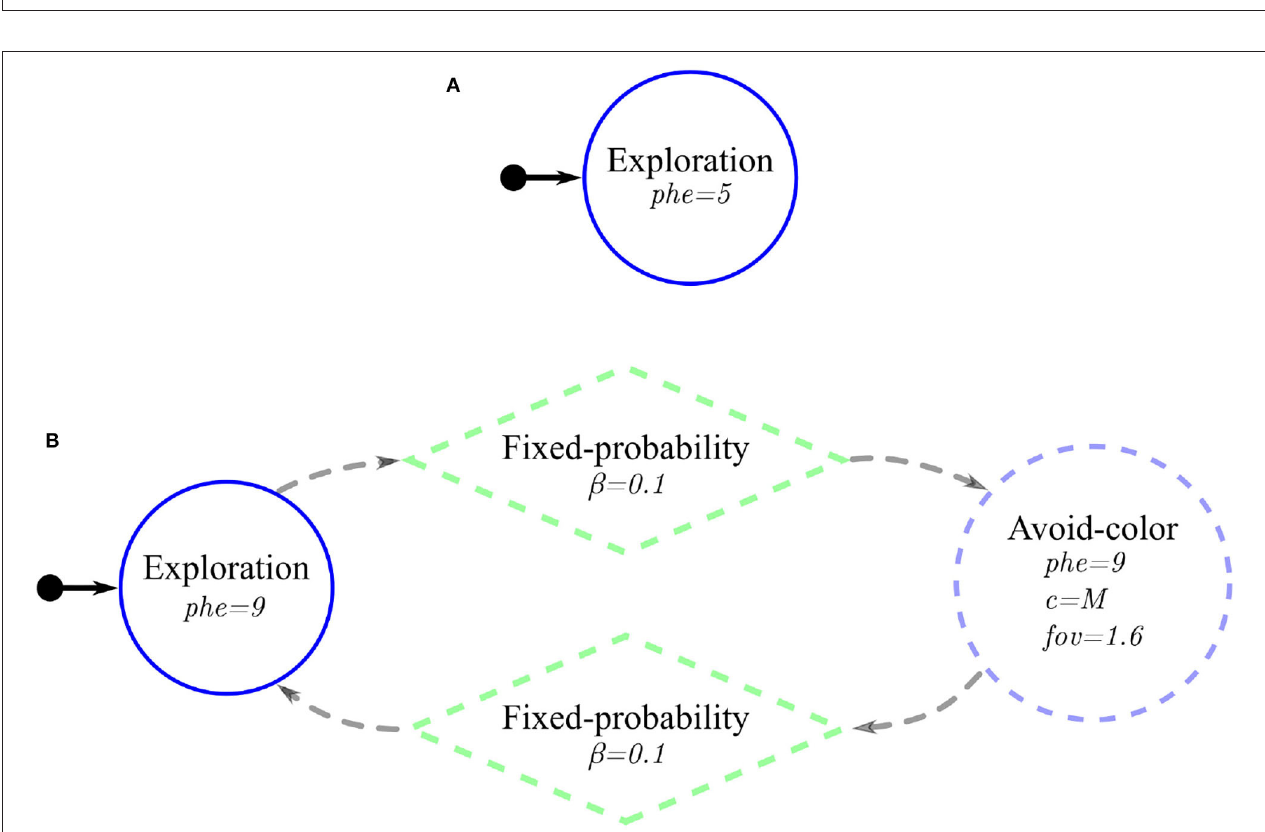
FIGURE 4 | Construction of arena for the COVERAGE experiments: (A) technical representation of the arena with dimensions of mesh, and (B) real arena. Measurements are expressed in meters.